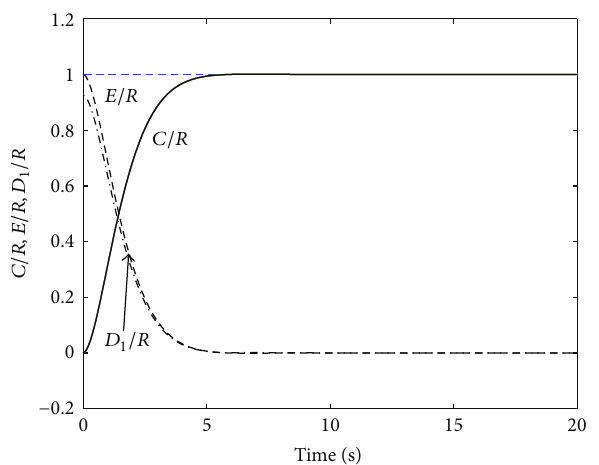
Figure4:Timeresponsesoftheillustratingexamplefor 𝑅 = 1,5, 10 , and 50 and 𝐷 1 = 0.925|𝐸| .